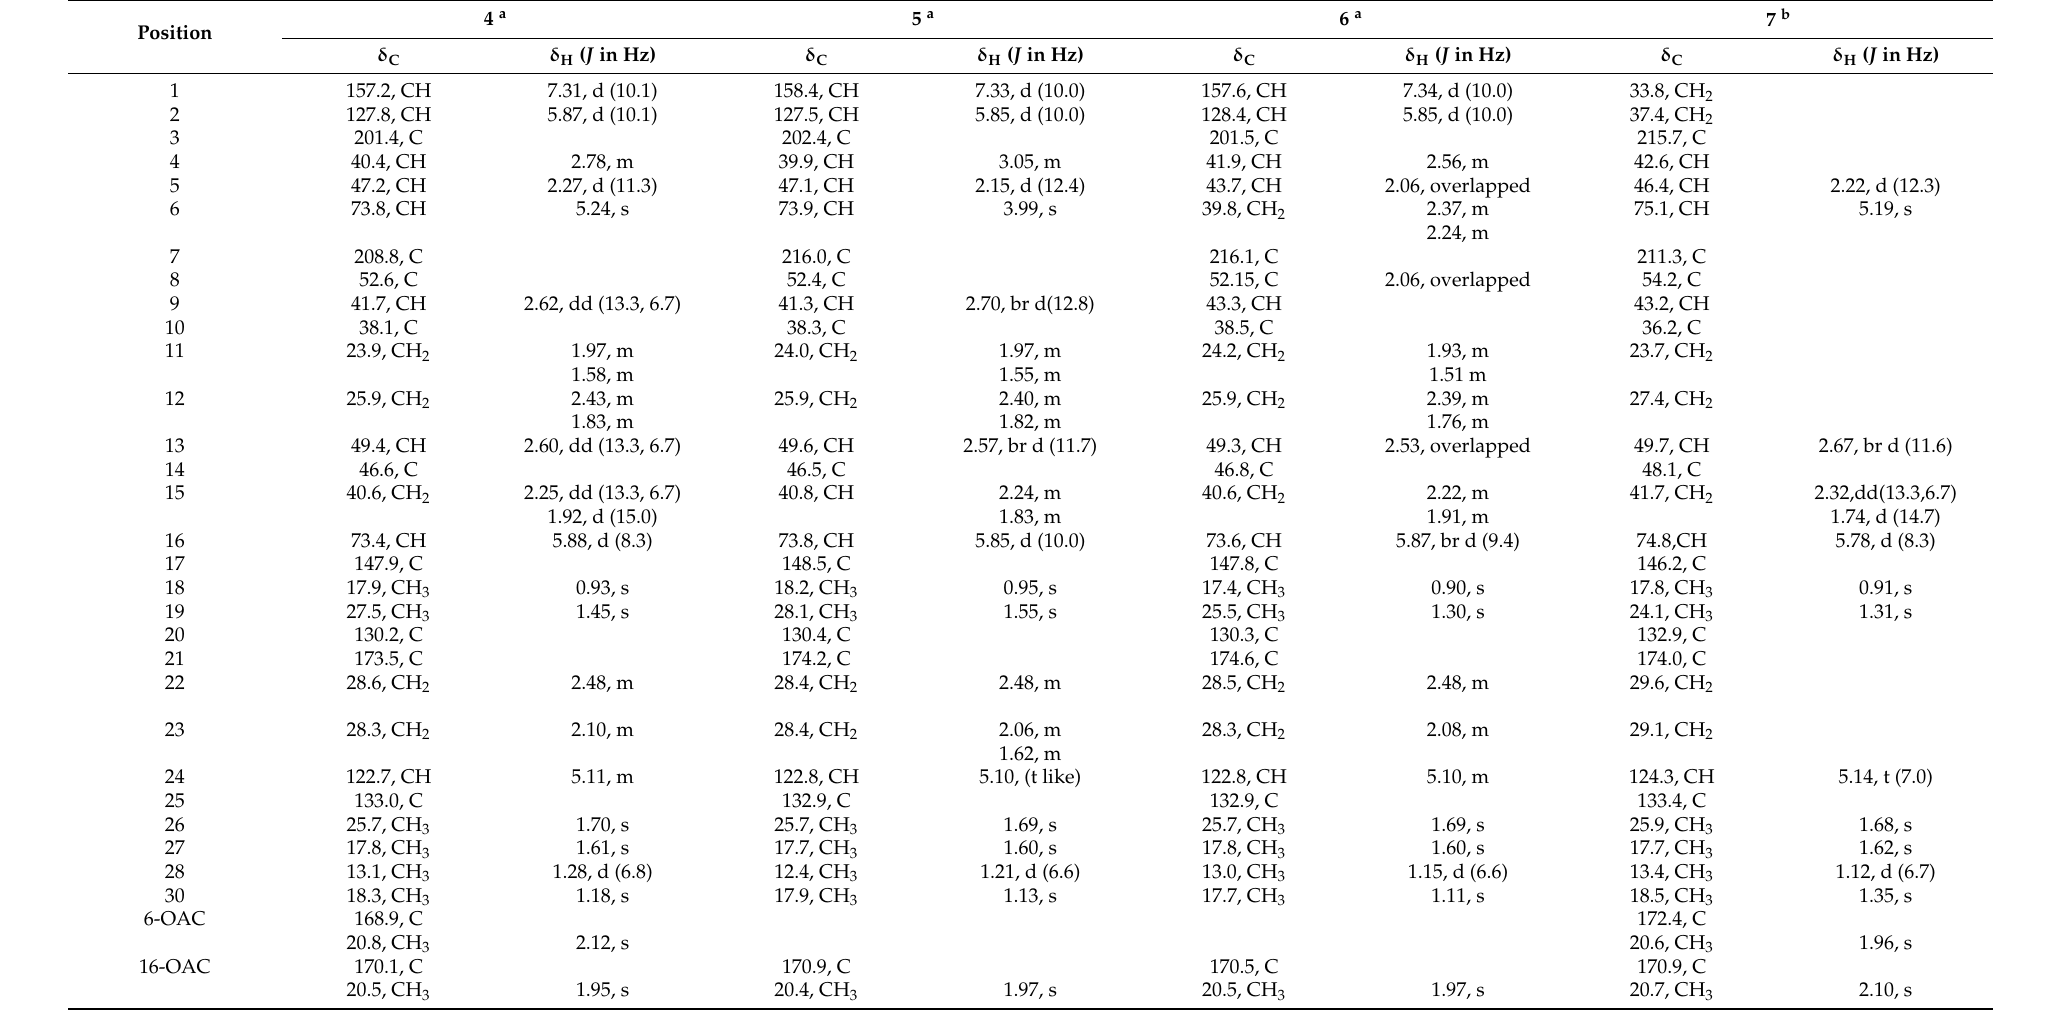
Table 2. 1 H (400 MHz) and 13 C NMR (100 MHz) data of compounds